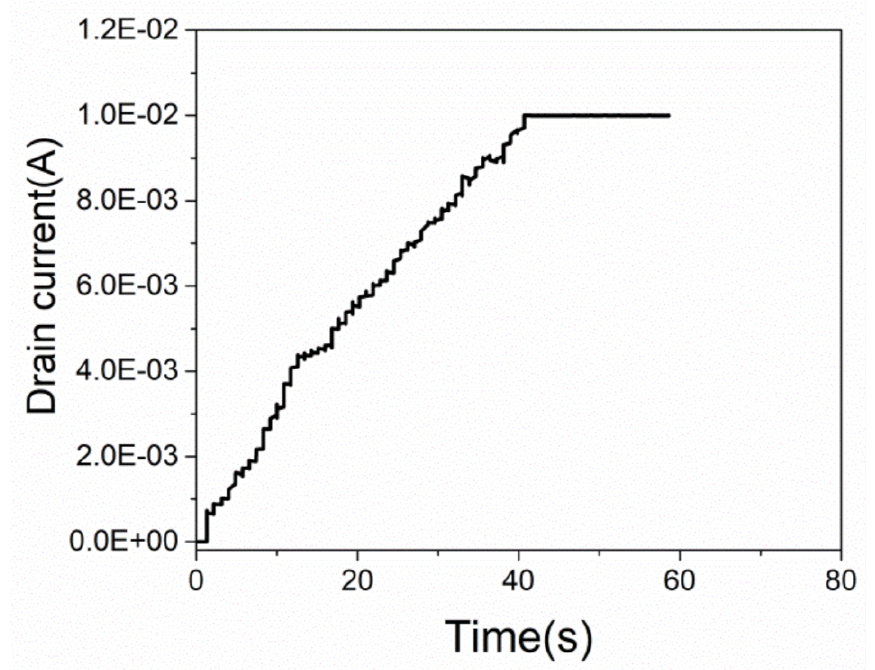
Figure 14. The drain currents of the device at V ds = 50 V for Ge ions at LET = 28.5 MeV · cm 2 /mg (about 0.31 pC/ µ m) .